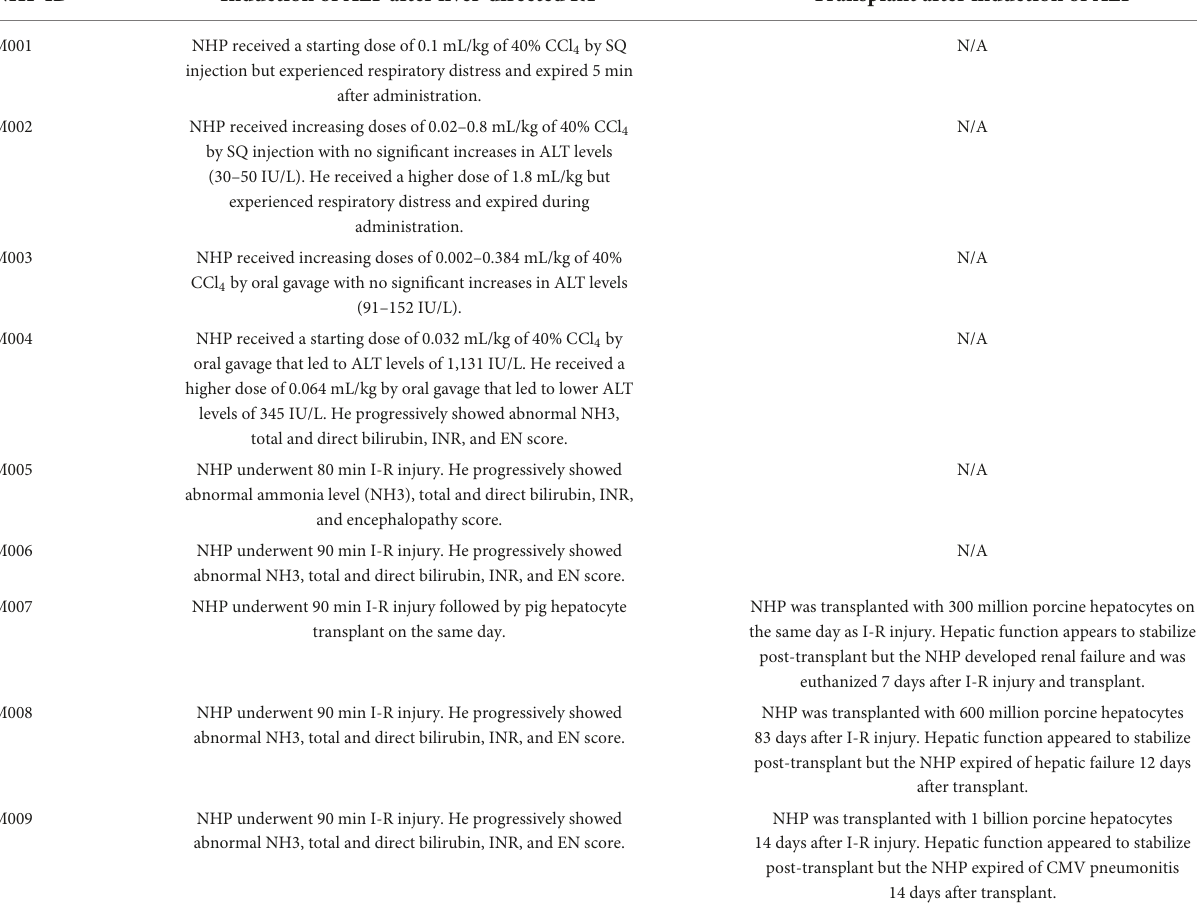
TABLE 1 Summary of procedures and findings in non-human